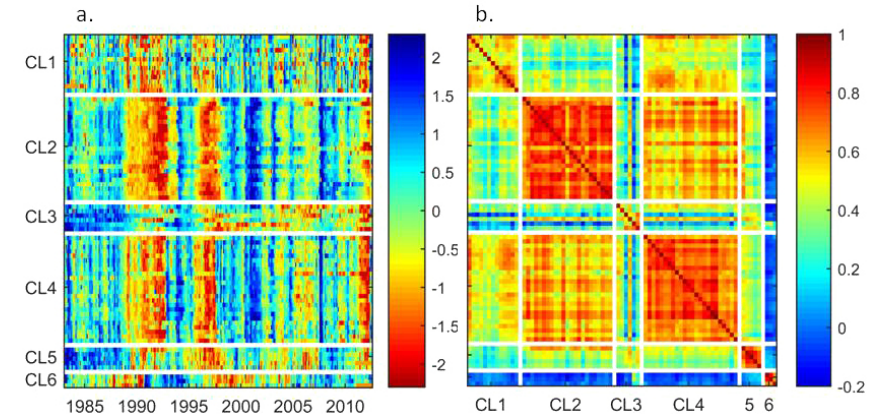
Figure 9. Heat maps showing (a) SGI varying with time for all 74 sites as a function of the six k -means clusters and (b) correlations between all pairs of sites sorted as a function of the six k -means clusters.